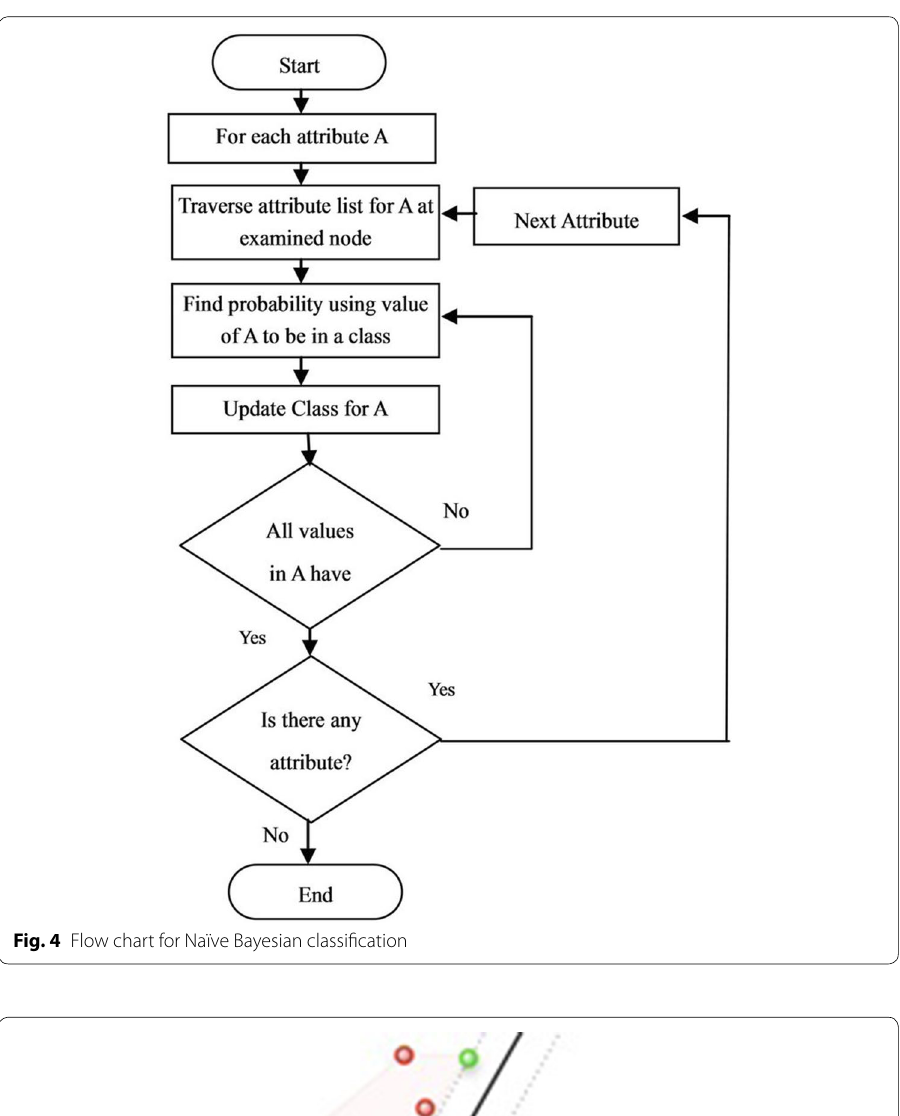
Fig. 4 Flow chart for Naïve Bayesian classification